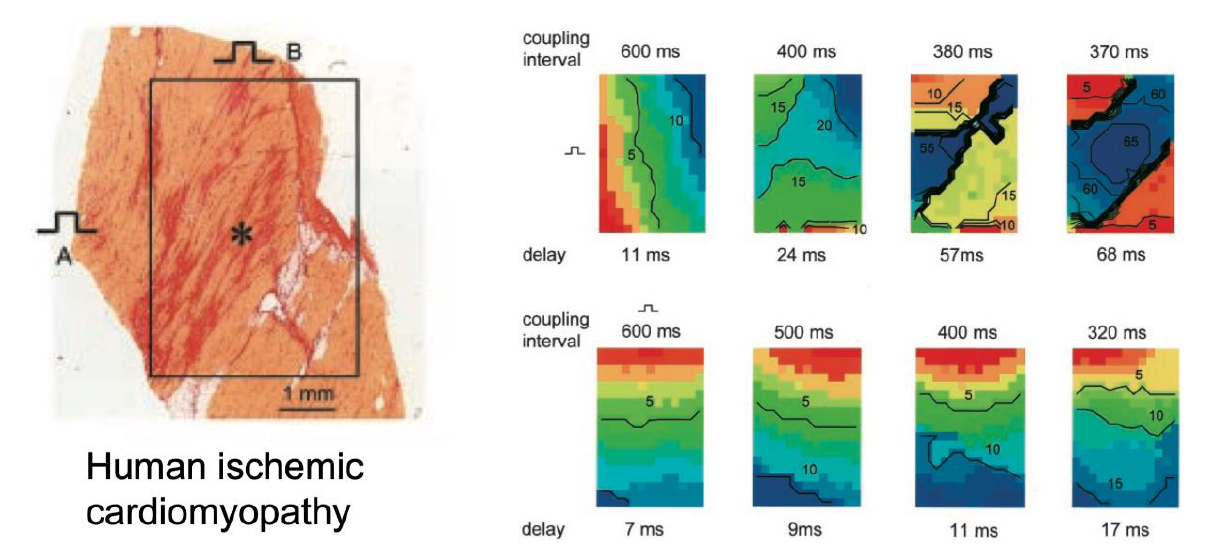
Figure 6. Impact of fibrotic strands in ventricular cardiomyopathy. In an explanted epicardial tissue slice with long strands of fibrosis, conduction patterns during extrastimulation with progressively shorter intervals were recorded for two different pacing sites (top and bottom row). During pacing at site B, the longitudinal wavefront showed a modest decrease in conduction velocity (bottom row), while at pacing site A, the propagating wavefront showed pronounced transverse conduction block, adapted from [68].